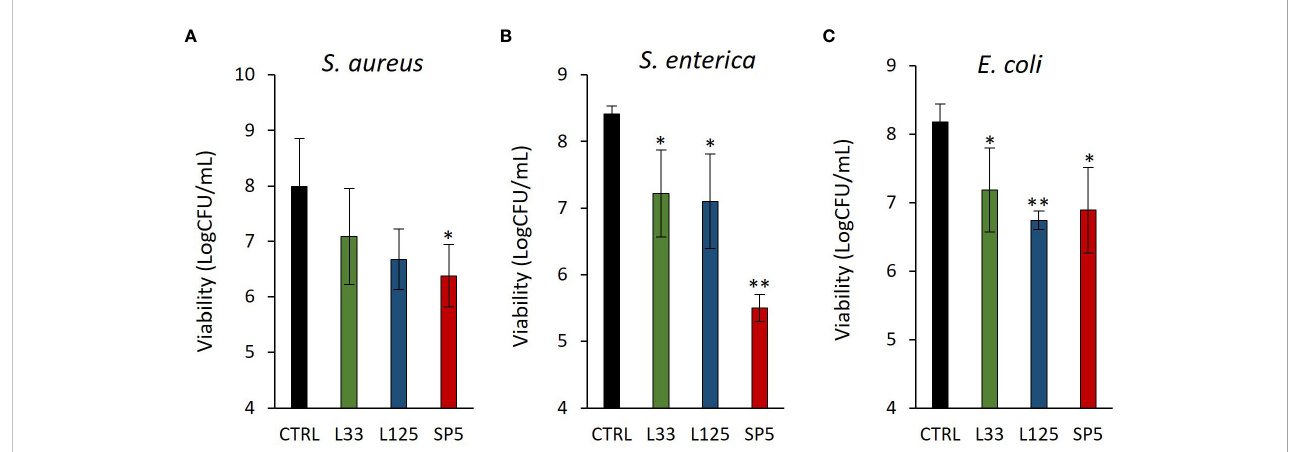
FIGURE 4 Anti-bio fi lm activity of CFCS derived from the novel lactobacilli against the enteropathogens (A) S. aureus , (B) S. enterica (C) and E . coli . Viability of the bio fi lm is expressed as Log CFU/mL. Results are expressed as the mean ± standard deviation of three independent experiments. * p < 0.05, ** p < 0.01 compared to untreated